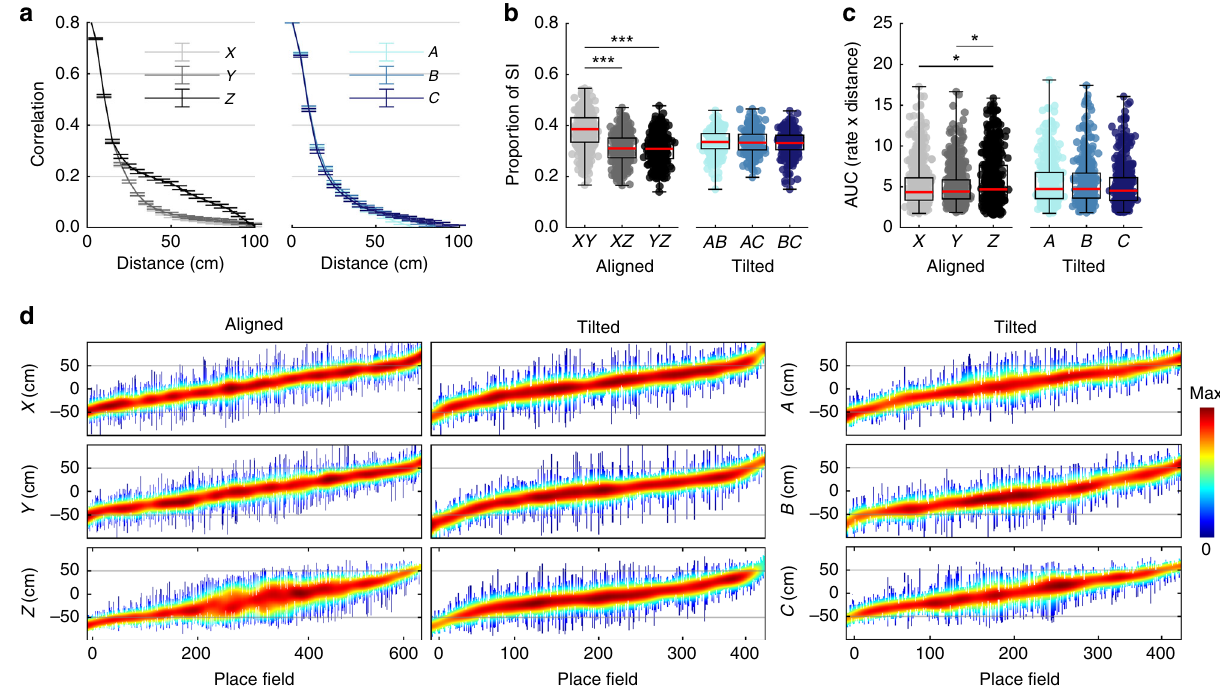
Fig. 8 Spatial information was lowest along the Z dimension of the aligned lattice. Source data are provided as a Source Data fi le. Omnibus test results can be seen in Table 1; post hoc test results are displayed here: *signi fi cant at the 0.05 level, **signi fi cant at the 0.01 level, ***signi fi cant at the 0.001 level. a Mean and SEM autocorrelation found for all place cells in the aligned lattice (left) and tilted lattice (right) at increasing distances or spatial lag. b Proportion of total spatial information found per projection for the aligned lattice (left) and tilted lattice (right). c Area under the fi ring rate curve (AUC) produced when place fi elds are projected onto each axis for both lattice mazes. d Span and normalized activity of every recorded place fi eld in the lattice mazes. Vertical lines represent place fi elds, ordered along the x-axis by their position relative to the lattice central node. Line color represents normalized fi ring